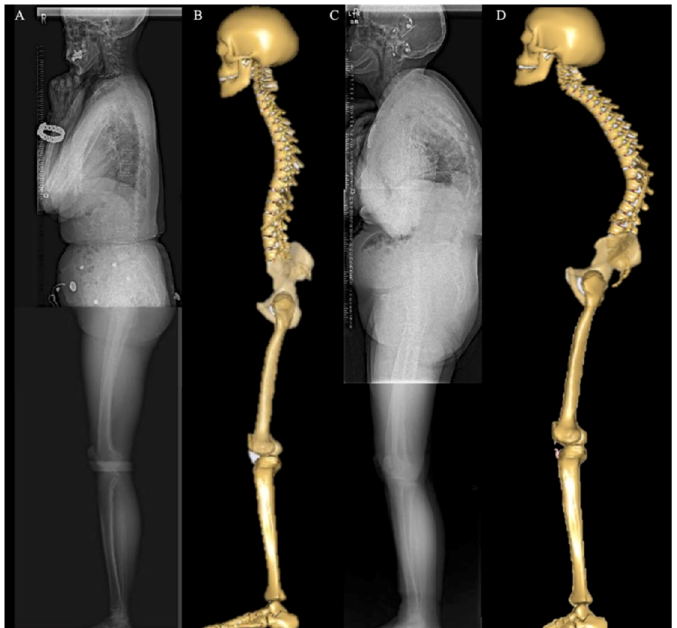
Figure 7. Example cases of low SVA and high SVA patients. ( A ) Lateral radiographs of the whole spine and lower extremity in the standing position in an 80-year-old female. ( B ) The musculoskeletal model with input of the patient’s alignment parameters. ( C ) Lateral radiographs of an 86-year-old female. ( D ) The musculoskeletal model of the